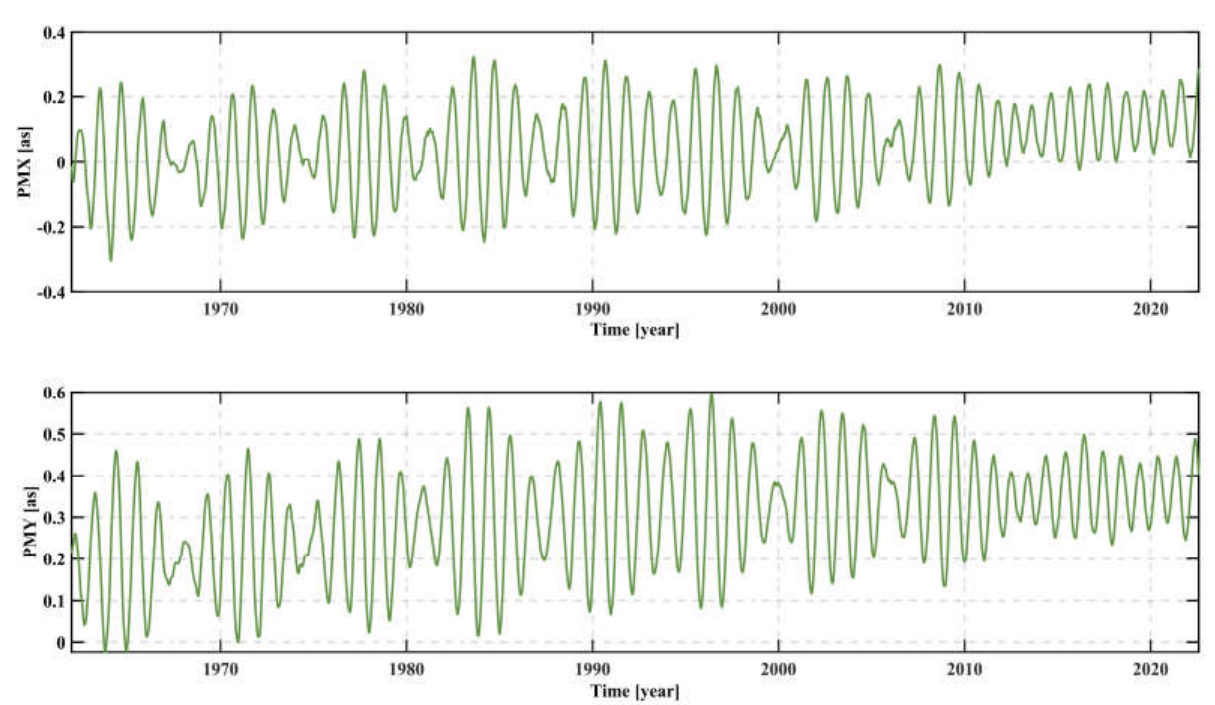
Figure 5. Polar motion time series from 1 January 1962 to now (MJD: 37665-59793); PMX, PMY represent the x and y components of polar motion series respectively.